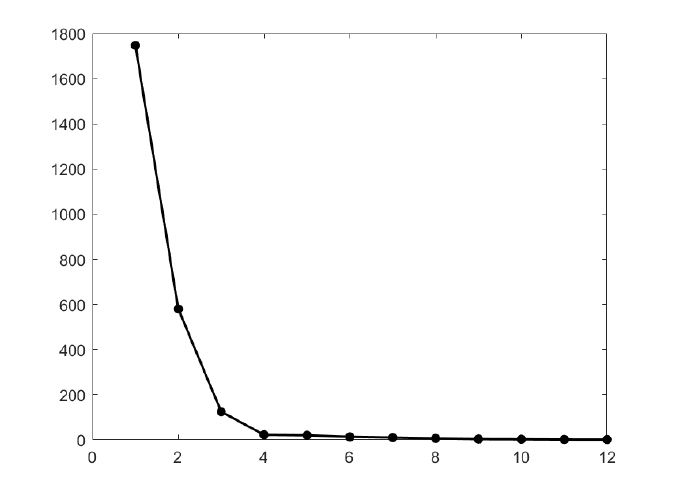
Figure 16. The first 6 principal components of the HI data set. Our PCA accelerator in Zedboard produces the first 3 outputs (PCA1 to PCA3).